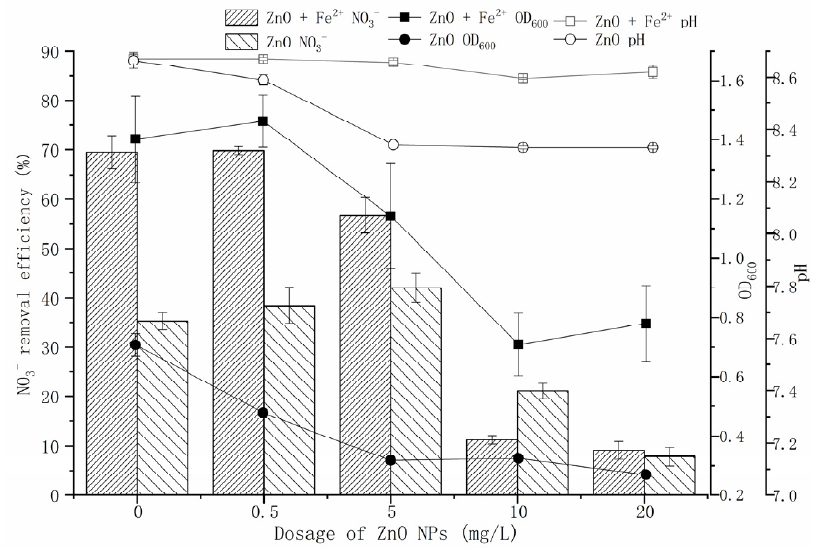
Figure 1. Effect of Fe 2+ on the proliferation and NO 3 − removal of P. tolaasii Y-11 under ZnO-NPs NPs stress.